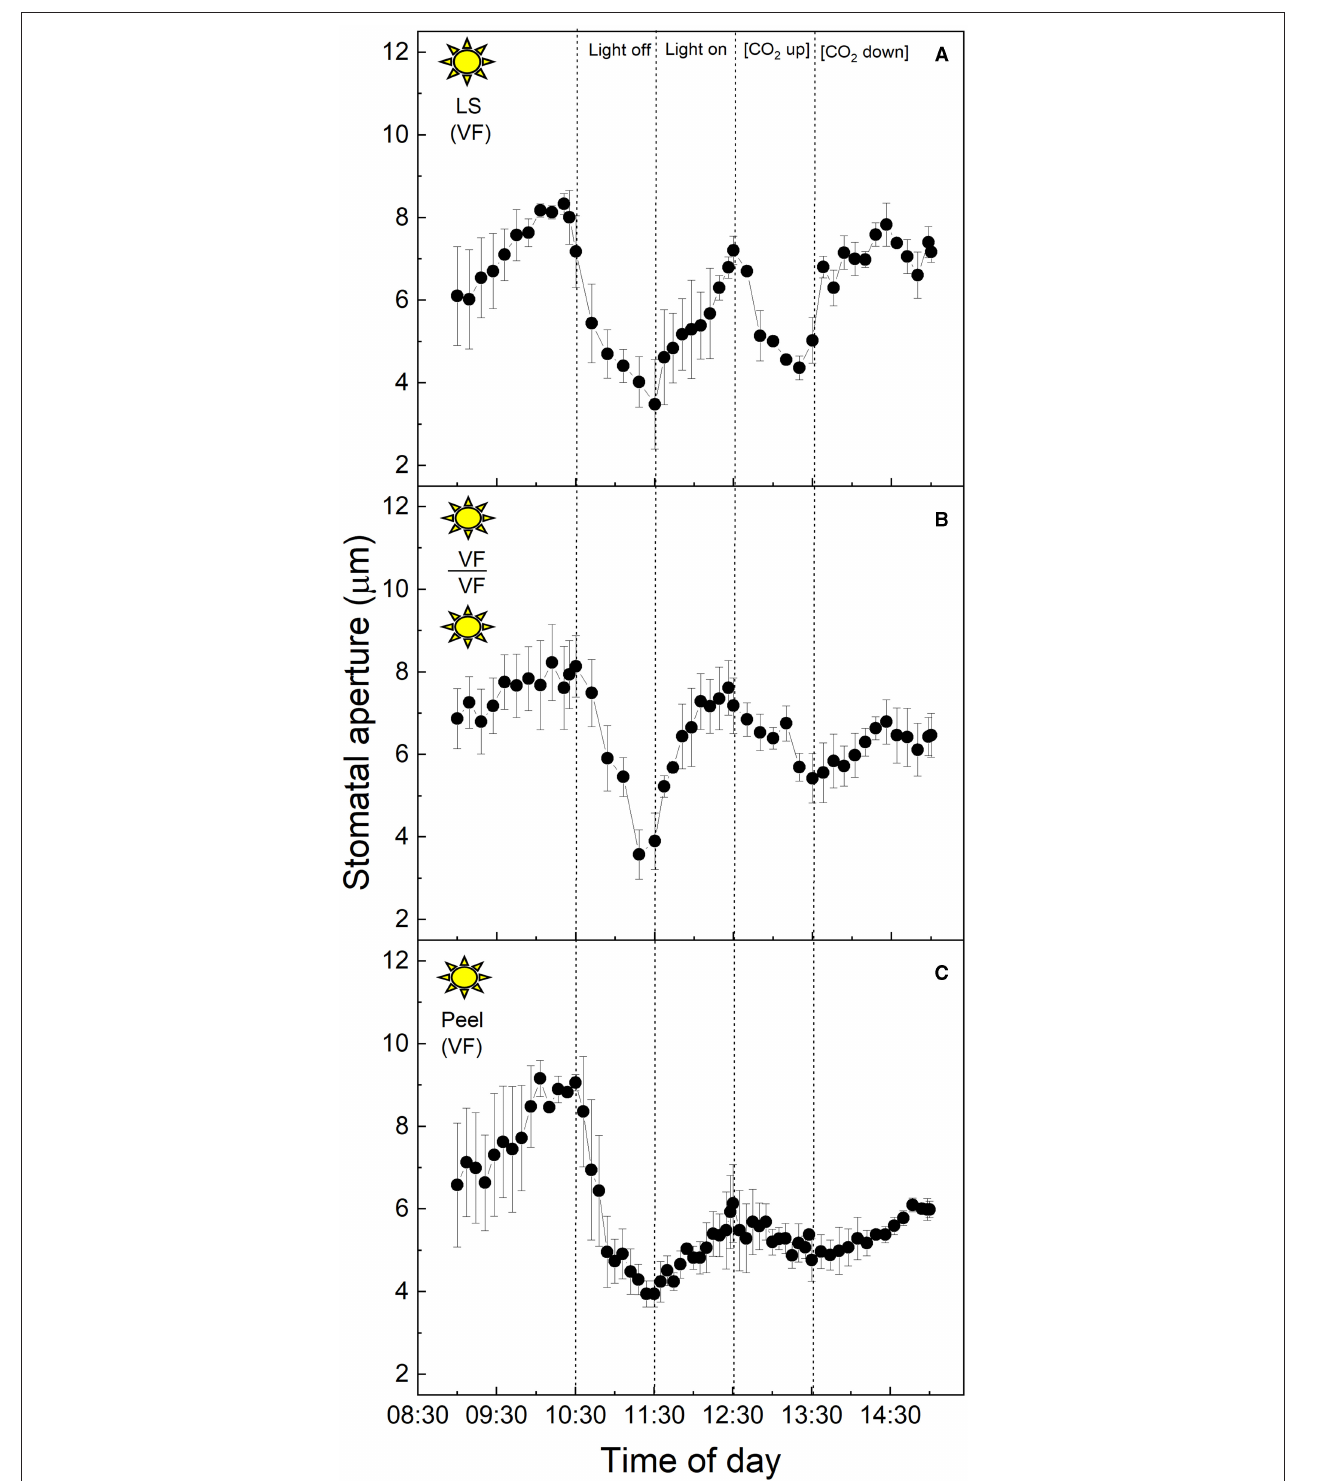
FIGURE 1 | (A) Vicia faba leaf segment; (B) Abaxial peeled epidermis of Vicia faba leaf on abaxial exposed mesophyll of Vicia faba , from the “light” growth chamber; (C) Abaxial isolated epidermis of Vicia faba leaf, from the “light” growth chamber (normal light period 8:00a.m. to 8:00 p.m.). Light intensity was changed from photon flux density of 400 ± 10 µ mol m − 2 s − 1 to darkness, as indicated, and [CO 2 ] was changed from 120 to 650 µ mol mol − 1 , as indicated. The temperature of the chamber was maintained at 23 ± 1 ◦ C. The values are means of four repetitions ( ± SE). The sun symbol represents plants taken from the light-grown chamber.